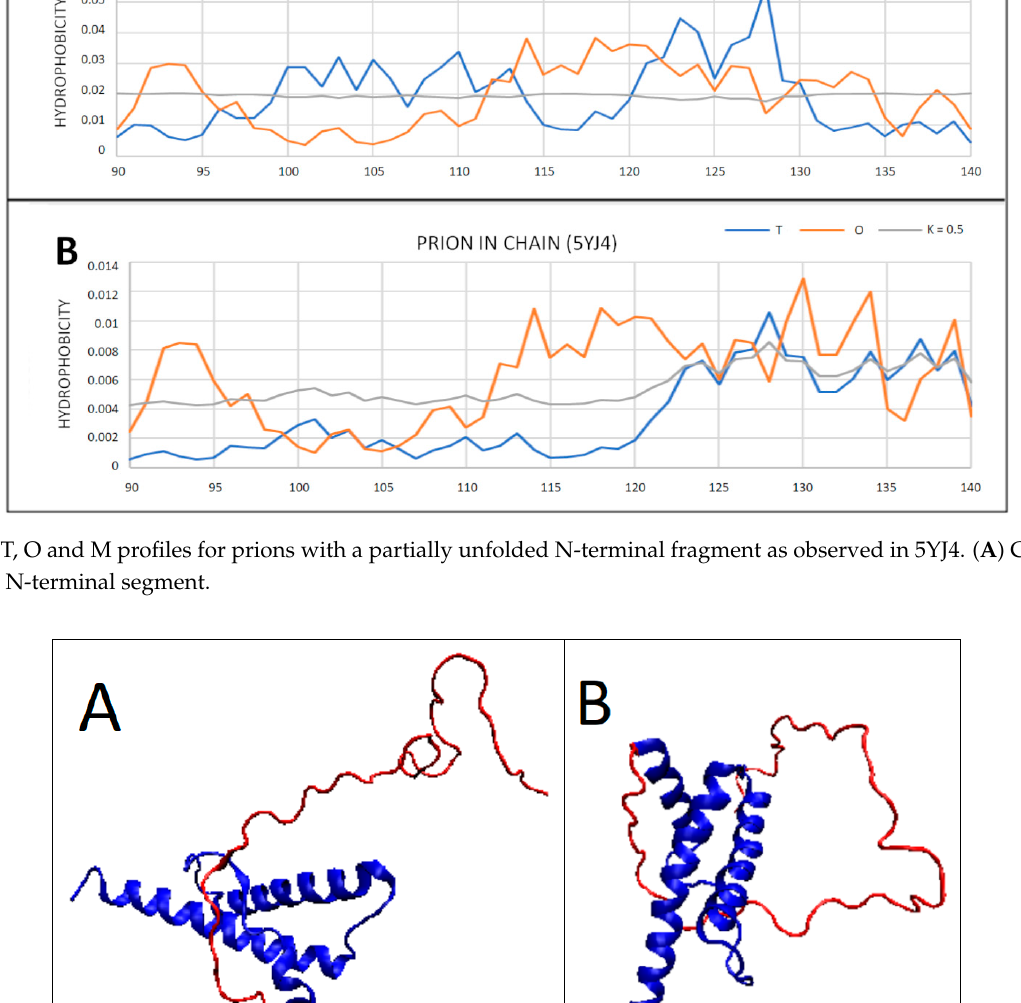
Table 3. Prion proteins for which their structure available in PDB are dimers. Dimer/Monomer PDB-ID